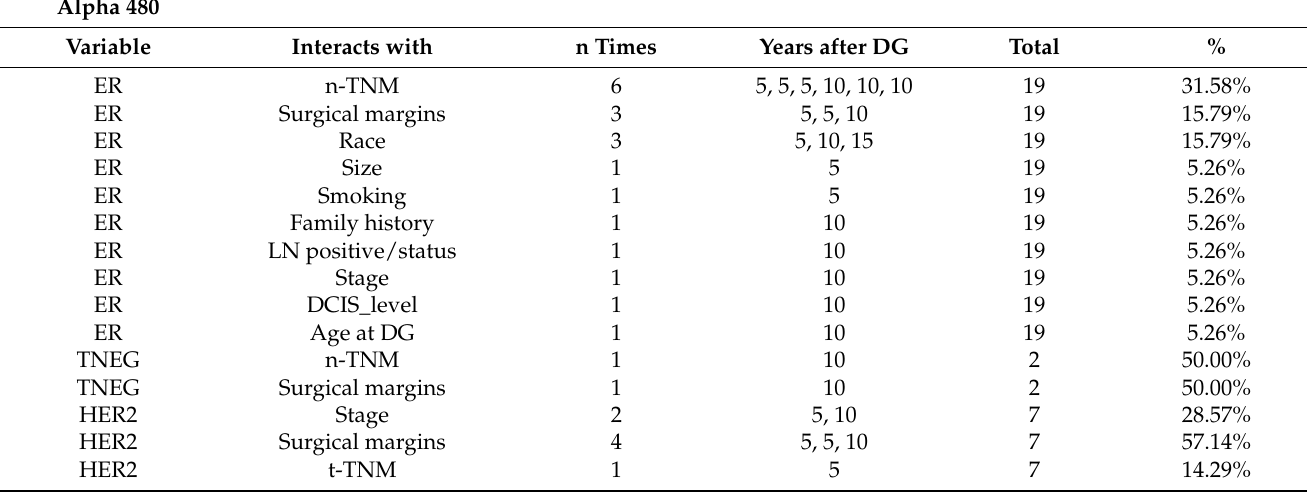
Table 4. Variables interacting with an alpha of 480. ER, TNEG, HER2, race/ethnicity and alco- hol/smoking are represented with their interacting variables, the number of times they interacted, the years after diagnosis when these interactions were found to be risk factors for metastases, the total number of times the variables interacted and frequency of